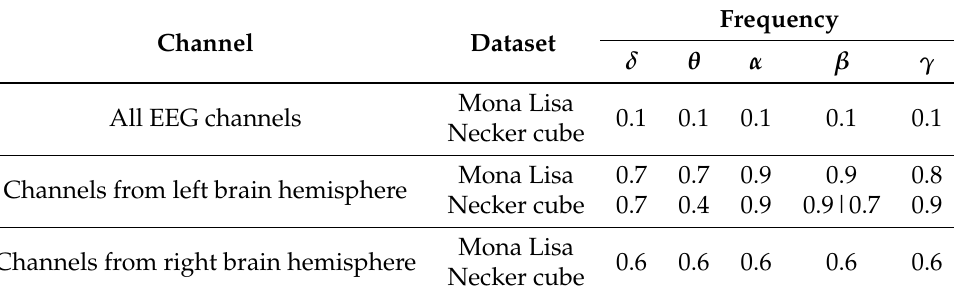
Table 15. The intensity which gives the maximal influence on the classification process for all participants in Case Study